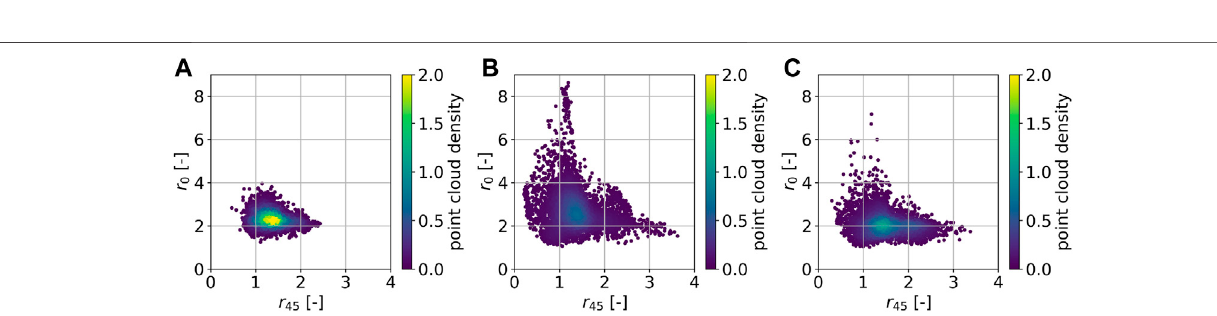
FIGURE 7 | 5,000 sampled texture-property data points projected into property space( E 0 , E 90 ). Data points are generated on the basis ofLatin hypercube design (A) , query-by-committee (B) and extended query-by-committee with r ≤ 5.0 (C) .